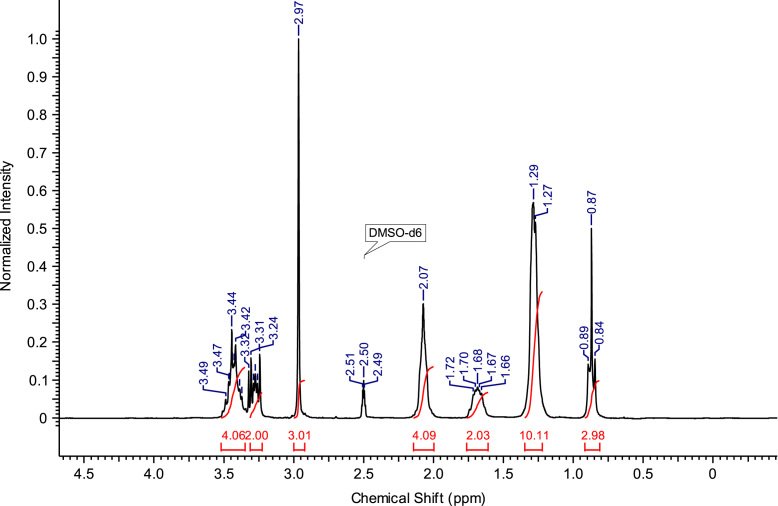
1H NMR spectra of C8(MPyrr)SbF6.